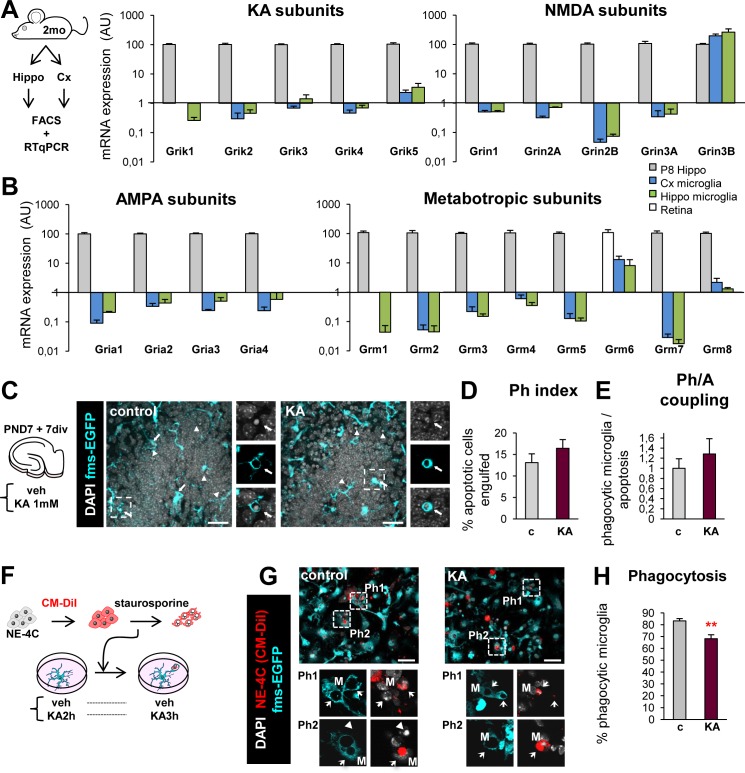
Phagocytosis impairment is not directly mediated by glutamate receptors on microglia.(A, B) Experimental design for RTqPCR expression of KA, NMDA, AMPA and metabotropic, receptor subunits in acutely purified microglia (FACS-sorted) from the hippocampus and the cortex of 2 mo mice (n = 4 samples of 8 pooled hippocampi and cortices each). The relative expression was compared to a positive control, a PND8 hippocampus, except for Grm6, where the retina from a 2-mo mouse was used. L27A was used as a reference gene. Amplification plots and denaturing curves for each target gene are shown in S9 Fig. (C) Experimental design and representative projections of confocal z-stacks of organotypic slices from fms-EGFP mice treated with vehicle (control) or KA (1 mM) for 6 h. The number of apoptotic cells, Ph capacity, and number of microglia in the DG is shown in S10A–S10C Fig. (D) Ph index in the DG organotypic slices (in % of apoptotic cells). (E) Ph/A coupling (in fold-change) in organotypic slices treated with KA. (F) Experimental design to test the effect of KA on microglial phagocytosis in vitro. Primary cultures were pre-treated with KA (1 mM) for 2 h prior to adding apoptotic NE-4C cells (treated with 5 μM CM-DiI for 25 min and 10 μM staurosporine for 4 h). NE-4C cells were left in the culture for another 3 h in the presence or absence of KA. (G) Representative confocal z-stacks of fms-EGFP+ microglia phagocytosing apoptotic CM-DiI+ NE-4C cells. (H) Percentage of phagocytic microglia in cultures (n = 2 independent experiments in triplicate). Bars represent mean ± SEM. ** indicates p < 0.01 by Student´s t test (H). Scale bars = 30 μm (C, G). z = 6.3 μm (F, J). Underlying data is shown in S1 Data.